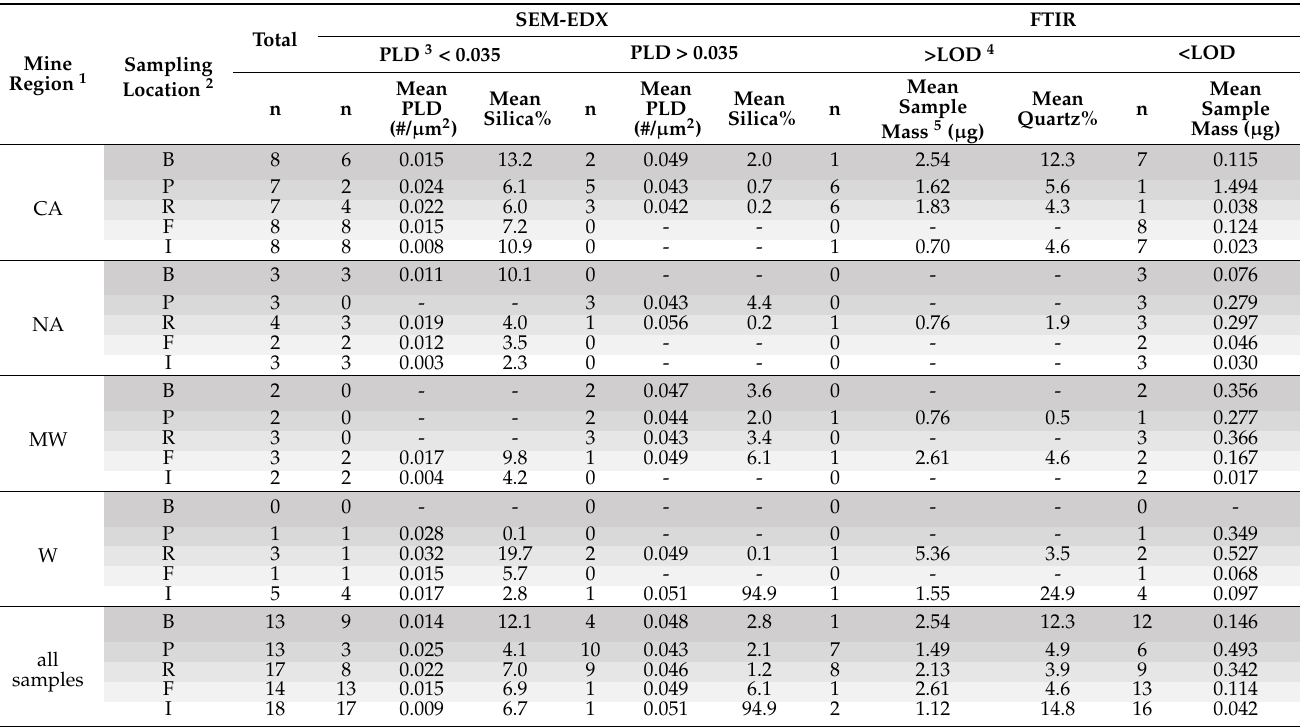
Table 3. SEM-EDX and FTIR results for RCMD samples summarized by sampling location and mine